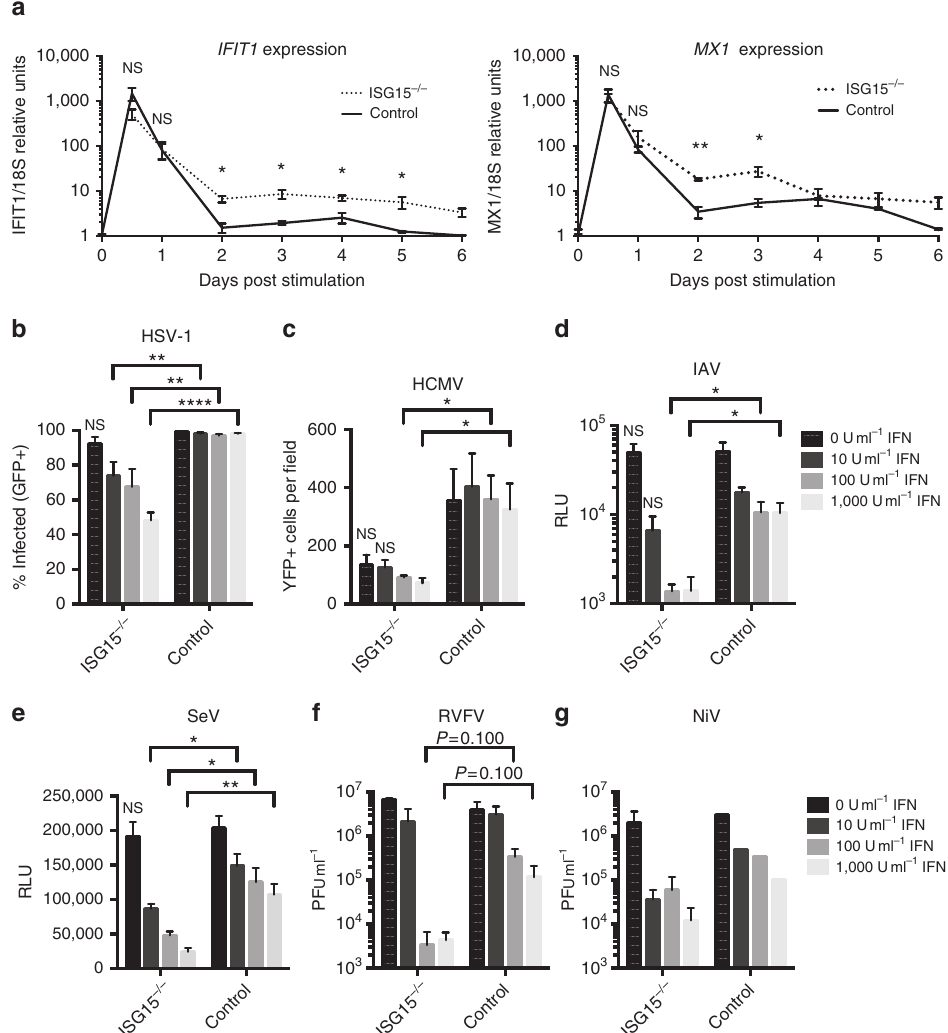
Figure 1 | ISG15 -deficient cells exhibit prolonged ISG expression and resistance to infection with viruses from multiple families. hTert-immortalized fibroblasts from ISG15 -deficient patients ( n ¼ 3) or controls ( n ¼ 5) were treated with the indicated concentration of IFN- a 2b for 12h, washed, and allowed to rest for 36h before infection. ( a ) Relative IFIT1 (left panel) or MX1 (right panel) mRNA levels at 12 (time of IFN- a 2b removal), 24, 48, 72, 96, 120 and 144h post-priming with 1,000IUml (cid:2) 1 . ( b ) Cells were infected with HSV-1-US11-GFP at a multiplicity of infection (MOI) of 1.0 for 24h, fixed, subjected to Hoechst 33342 nuclear staining, and imaged. Shown are the percentages of cells positive for both GFP and nuclear staining. ( c ) Cells were infected with HCMV-IE2-YFP at an MOI of 2.0 for 24h, fixed, and imaged. Shown are the numbers of GFP-positive cells field (cid:2) 1 . ( d ) Cells were infected with IAV PR8-gLuc-PTV1 at an MOI of 10.0 for 24h. Lysates were collected and assayed for luciferase activity. Shown are the results in relative luminescence units. ( e ) Cells were infected with SeV-GFP-gLuc at an MOI of 0.1 for 24h. Supernatants were collected and assayed for luciferase activity. Shown are the results in relative luminescence units. ( f ) Cells were infected with RVFVat an MOI of 0.01 for 48h. Supernatants were collected and titered by plaque assay. ( g ) Cells were infected with NiV-gLuc- P2A-eGFP at an MOI of 0.01 for 24h. Supernatants were titered by plaque assay. a shows the combined results of two experiments. b , c , and e show a single representative experiments of three performed. d shows the combined results of three experiments. f and g are single experiments performed in the BSL-4. Error bars, s.d. Comparisons made with unpaired t -test. * P o 0.05, ** P o 0.01, **** P o 0.0001. NS, not significant.